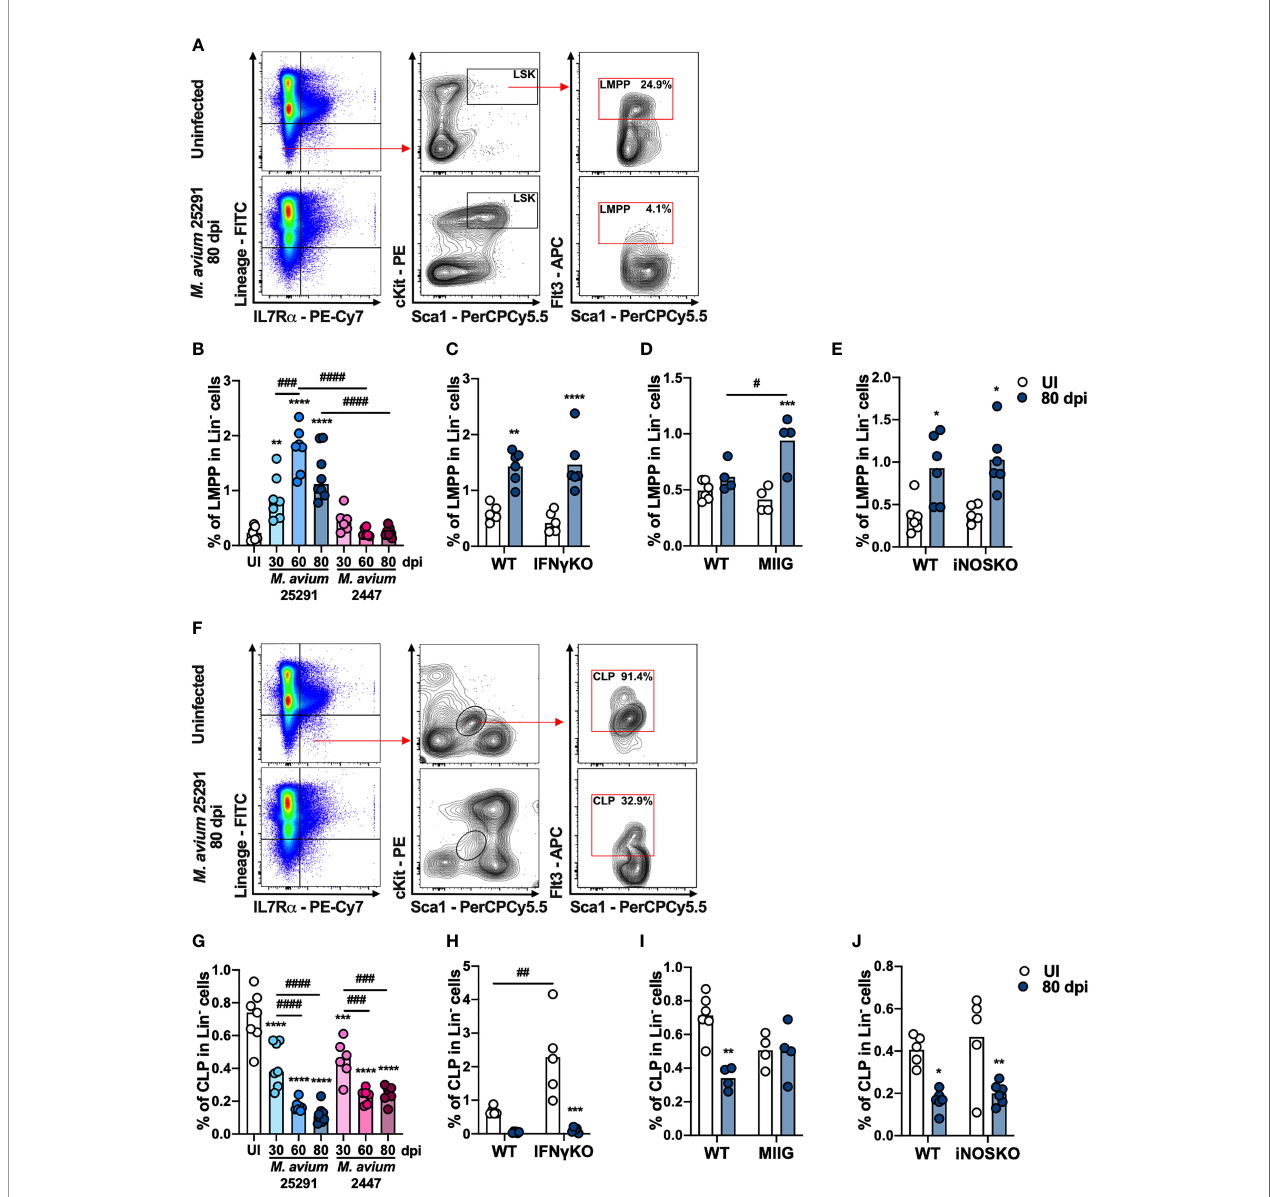
FIGURE 3 | The increase on the percentage of LMPP and the decrease on the percentage of CLP in mice infected with M. avium 25291 is independent on IFN g and iNOS. (A) Schematic representation of the gating used to select LMPP population in the BM from uninfected WT mice (top), or infected for 80 days with M. avium 25291 (bottom). Total BM cells were previously selected eliminating doublets and debris. (B) Percentage of LMPP in the lineage negative population from uninfected (white) WT mice or infected with M. avium strain 25291 (blue) or strain 2447 (pink) at 30, 60 and 80 dpi. (C – E) Percentage of LMPP in the lineage negative population from uninfected (white) or infected for 80 days with M. avium 25291 (blue), WT, IFN g KO, MIIG or iNOSKO mice. (F) Schematic representation of the gating used to select CLP population in the BM from uninfected WT mice (top), or infected for 80 days with M. avium 25291 (bottom). Total BM cells were selected eliminating doublets and debris. (G) Percentage of CLP in the lineage negative population from uninfected WT mice (white), or infected with M. avium strain 25291 (blue) or strain 2447 (pink) at 30, 60 and 80 dpi. (H – J) Percentage of CLP in the lineage negative population from uninfected (white) or infected for 80 days with M. avium 25291 (blue), WT, IFN g KO, MIIG or iNOSKO mice. In all graphs, bars represent the mean from 4 to 8 mice per group, from one of two independent experiments. In B and G comparisons between infected and uninfected mice were evaluated by ordinary one-way ANOVA followed by Dunnett ’ s multiple comparisons test and marked as: ** p < 0.01, *** p < 0.001, **** p < 0.0001; comparisons between infected groups were evaluated by 2-way ANOVA followed by Tukey ’ s multiple comparisons test and marked as: ### p < 0.001, #### p < 0.0001. In (C – E, H – J) , comparisons were evaluated by 2-way ANOVA followed by Tukey ’ s multiple comparisons test and marked as: * p < 0.05, ** p < 0.01, *** p < 0.001, **** p < 0.0001 for comparisons between uninfected and infected, and as: # p < 0.05, ## p < 0.01, ### p < 0.001, #### p < 0.0001 for comparisons between infected groups. UI stands for uninfected. dpi stands for days post